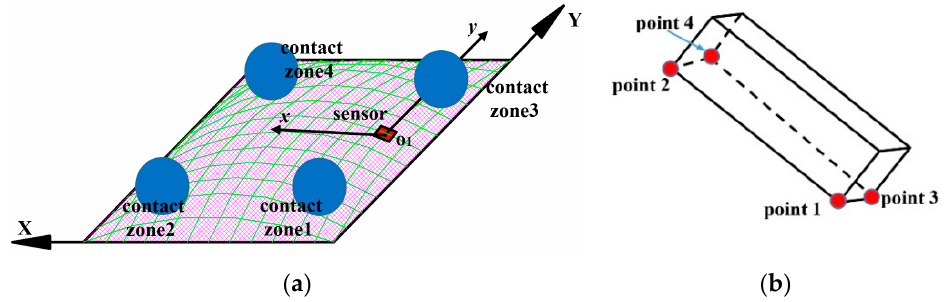
Figure 12. Divided contact zones on skin’s surface and intial posture of accelerometer. ( a ) Depending on location of indenter on skin’s surface, contact area can be categorized into four zones. ( b ) Posture of accelerometer under static pressurization without sliding actions.